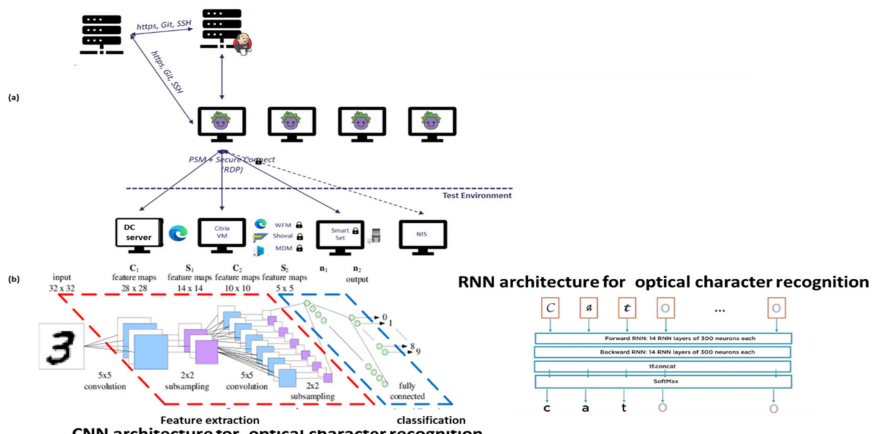
Figure 2. ( a ) How the “robotic process automation” is implemented on the smart metering system— schematic implementation using four “Eggplant software” licenses and accessing various components of the smart metering system. ( b ) OCR implementation using a convolutional neural network- left or recurrent neural network (LSTM) right. The OCR network is used by Eggplant for RPA